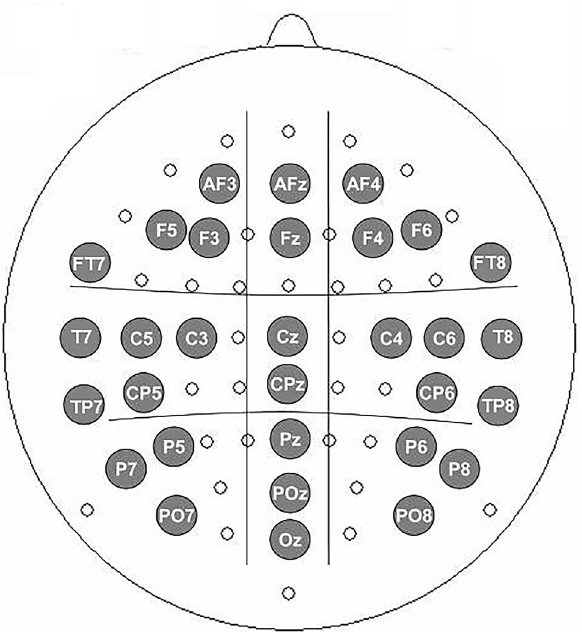
Figure 3. Electrode montages for the different scalp distribution of TBO